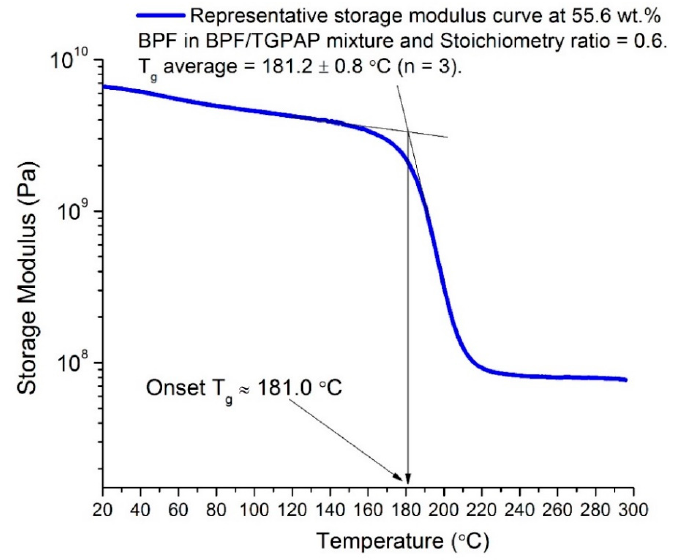
Figure 9. Determination of onset T g from a representative storage modulus curve at 55.6 wt.% BPF epoxy blend and stoichiometry ratio = 0.6.